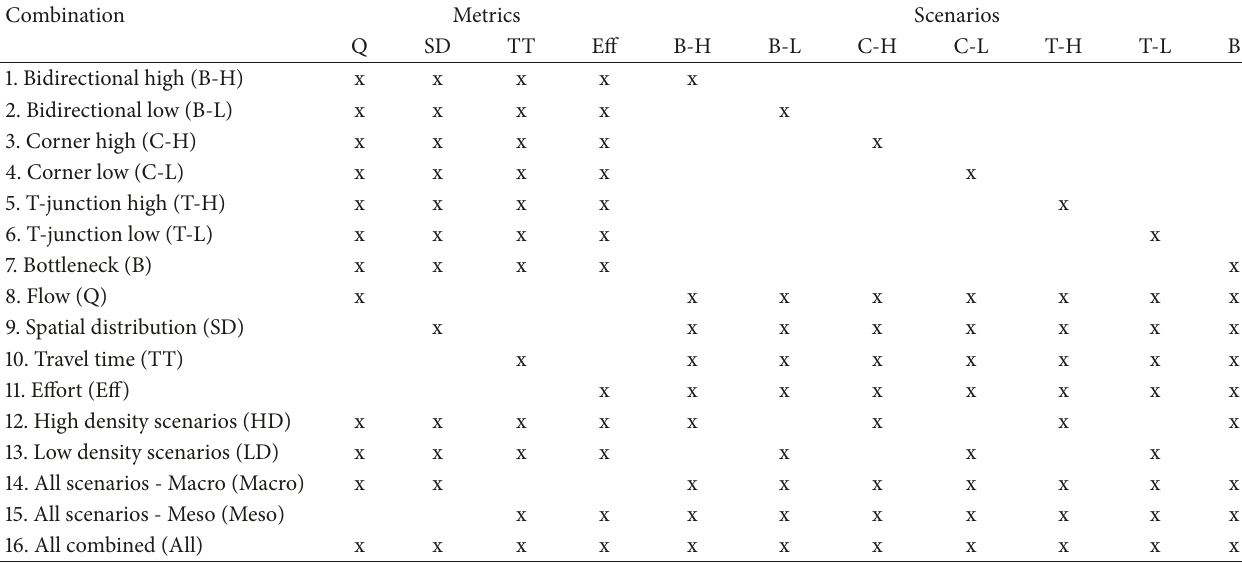
Table 3: Tested combination of scenarios and metrics, where the acronyms identify the metrics (i.e., Q = flow, SD = spatial distribution, Eff = effort, and TT = travel time) and the scenarios (i.e., B-H = bidirectional high, B-L = bidirectional low, B = bottleneck, C-H = corner high,